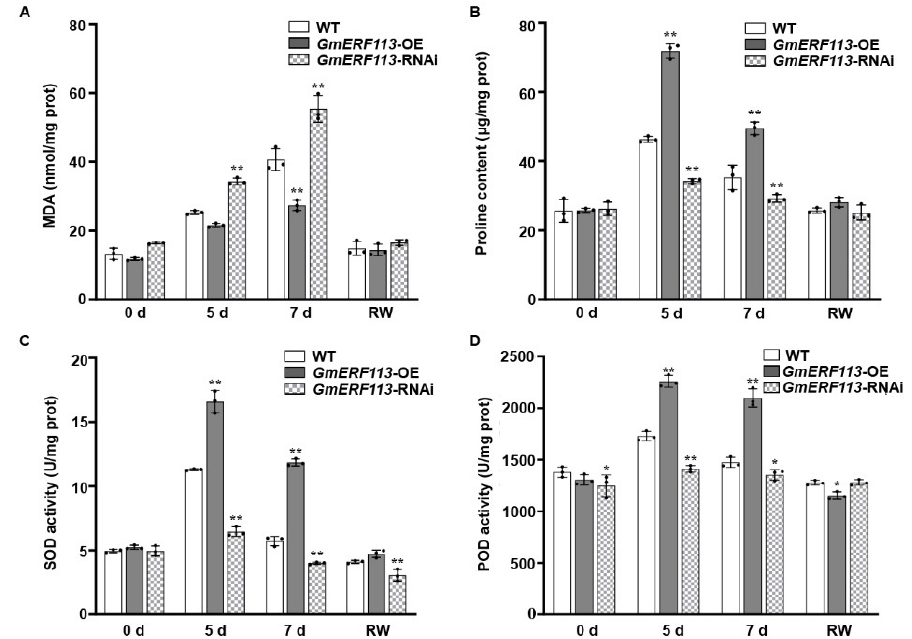
Figure 3. Overexpression or silencing of GmERF113 alters drought-related parameters that are reflective in soybean plants. ( A – D ) Malondialdehyde content (MDA; A ), proline content ( B ), and superoxide dismutase (SOD; C ) and peroxidase (POD; D ) activities of WT, GmERF113- OE, and GmERF113- RNAi soybean plants that were exposed to drought stress for 0, 5, and 7 days and re- watered for 2 days. The experiment was performed on three biological replicates, each with three technical replicates, and was statistically analyzed using Student’s t -test (* P < 0.05, ** P < 0.01). The bars indicate the standard deviation of the